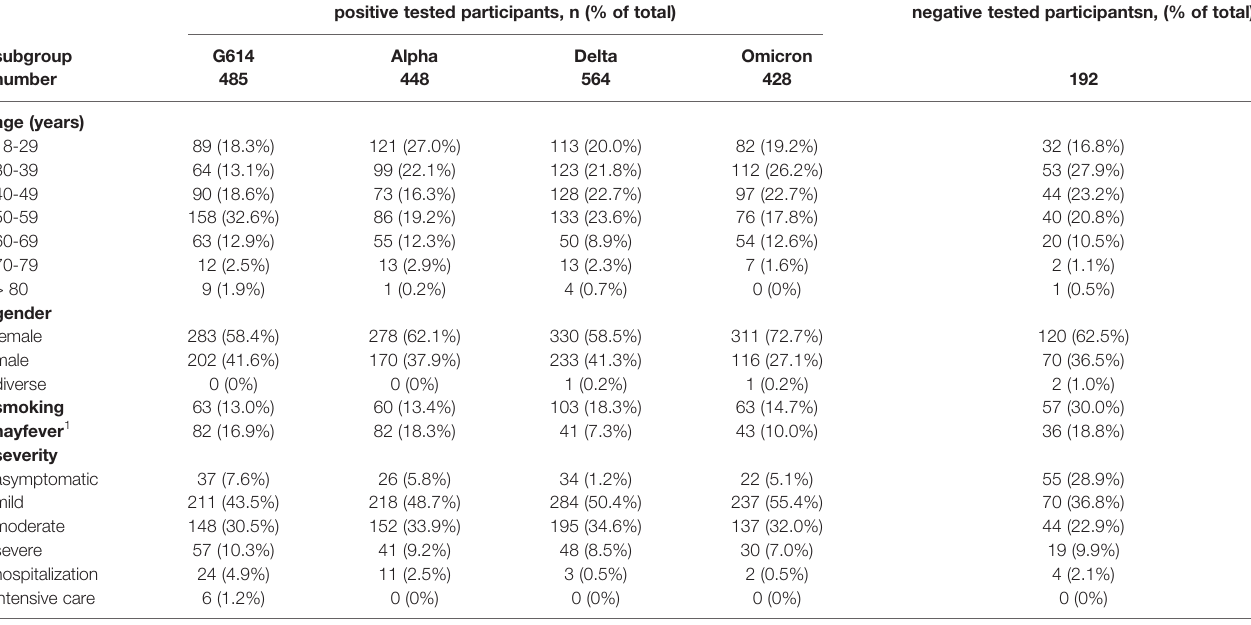
TABLE 1 | Characteristics of the study